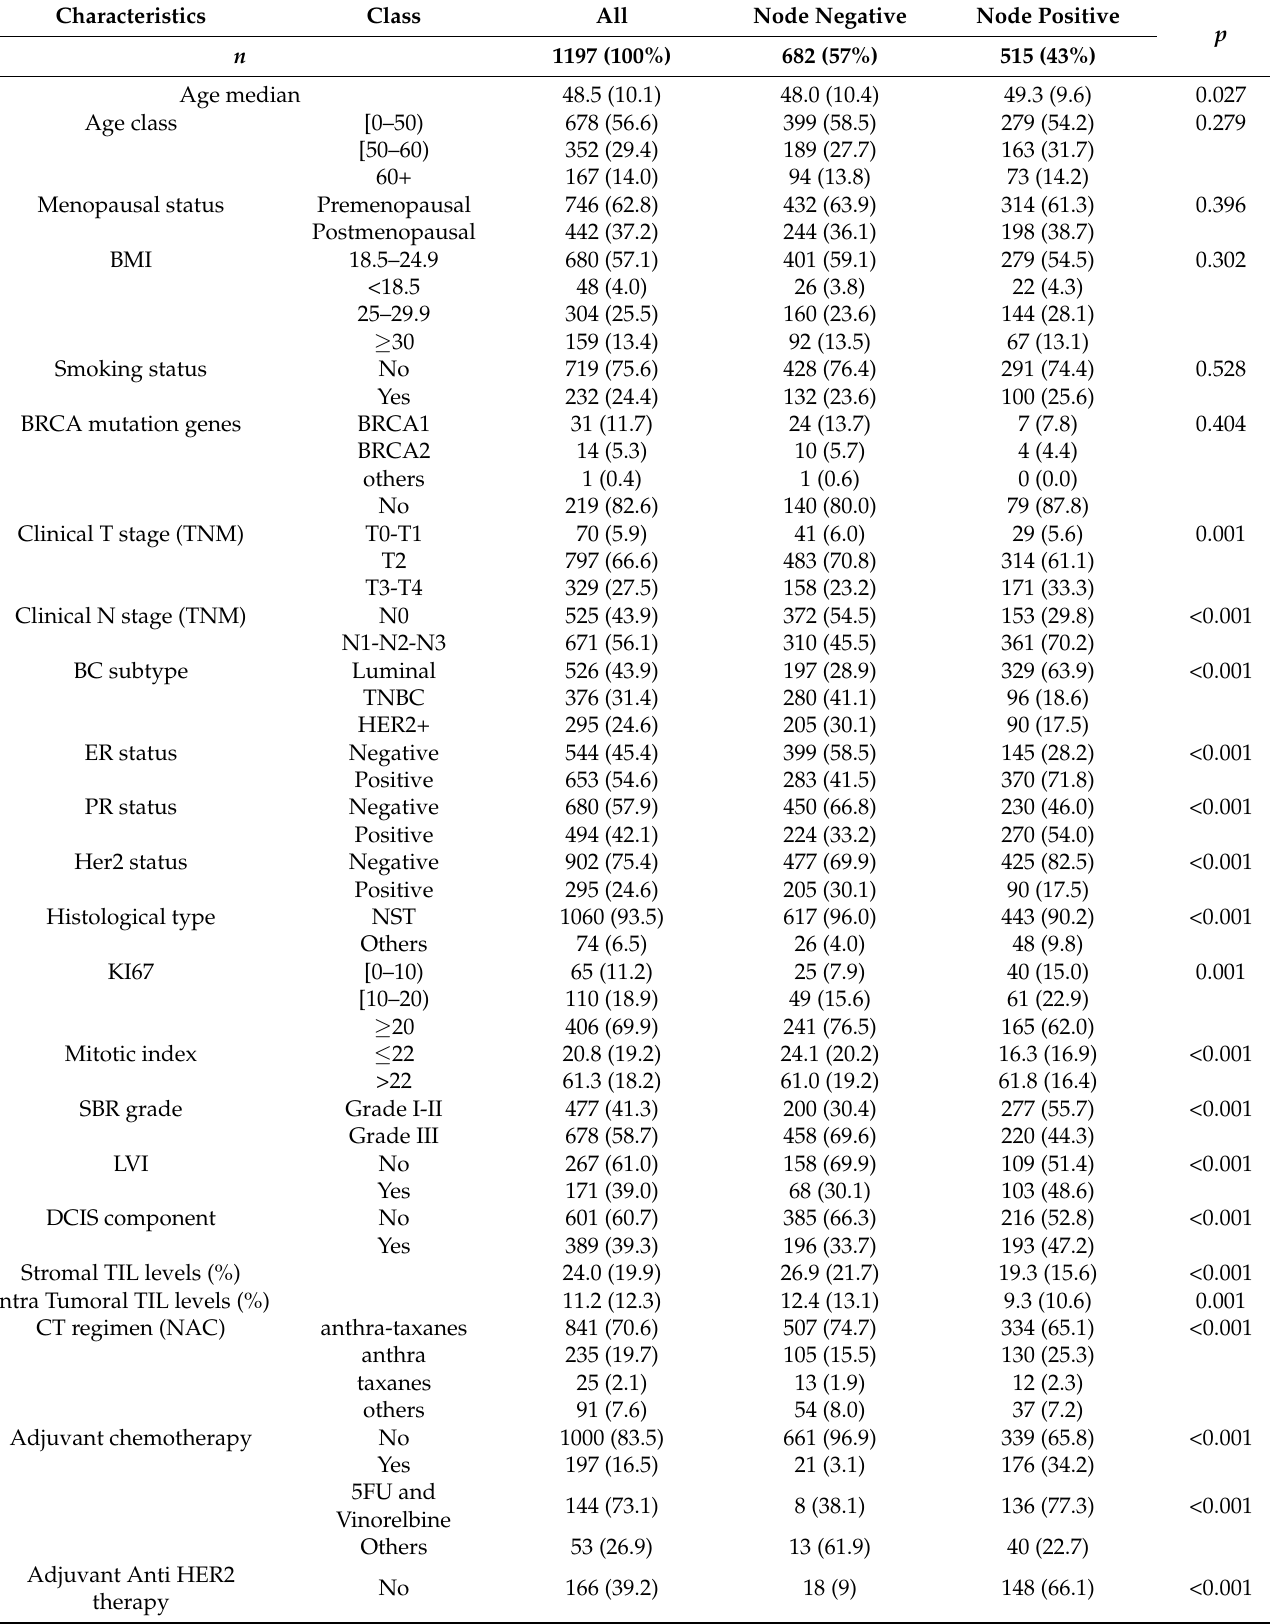
Table 1. Patients and tumor characteristics by post- neoadjuvant chemotherapy (NAC) nodal